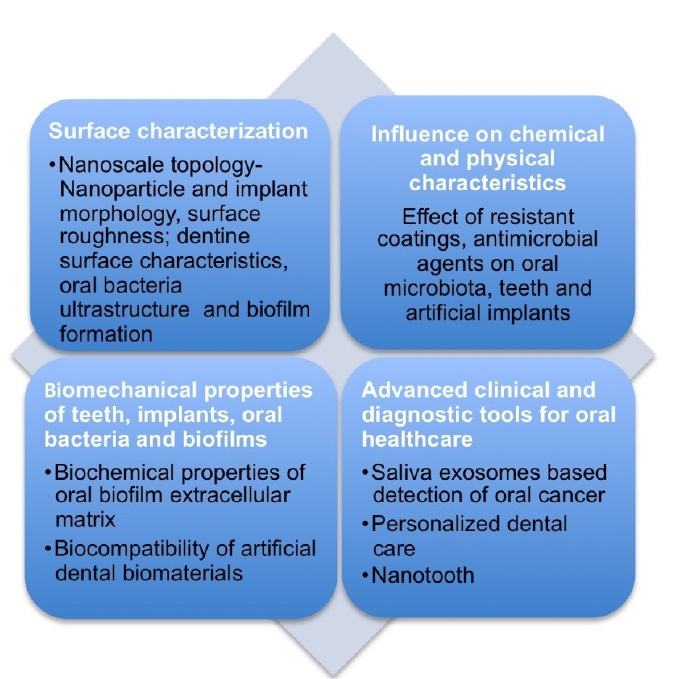
Figure 1. Atomic force microscopy (AFM) based nanoscale topographic, biophysical and biochemical characteristics of dental surfaces and